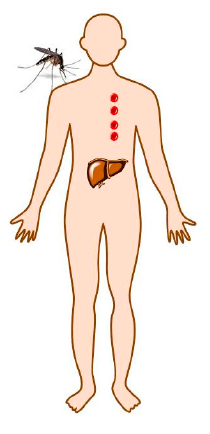
Figure 2. Life cycle of Plasmodium parasites: When an infected female Anopheles mosquito takes a blood meal approximately eight to 10 sporozoites are introduced into the blood. Either the sporozoites have entered hepatocytes after 45 min. or they are cleared. In the liver the sporozoites proliferate asexually for between 5 days ( P. falciparum ) and 15 days ( P. malariae ). A proportion of hepatic schizonts may rest in the liver as hyonozoites in the case of P. ovale and P. vivax infections. The hypnozoites may awake weeks or months after the infection. The merozoites delivered to the blood invade erythrocytes, feed on the proteins mainly hemoglobin and proliferate asexually. After 36 hours ( P. malariae , P. ovales , P. vivax and P. knowlesi ) or 54 hours ( P. malariae ) the cells rupture and release between 6 and 36 merozoites, which invade healthy erythrocytes. The characteristic fever attacks appear when the erythrocytes rupture. After a series of asexual proliferation gametocytes appear. Gametocytes are ingested during a blood meal of an Anopheles mosquito, in which they undergo a sexual proliferation [7].